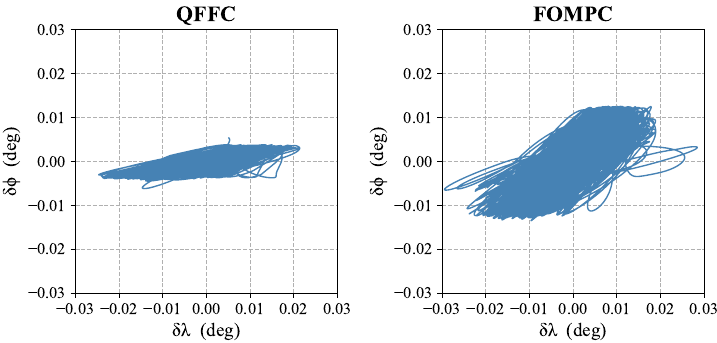
Figure 17. The trajectories in the ( δλ , δφ ) plane considering the maximum EDR of the determination.